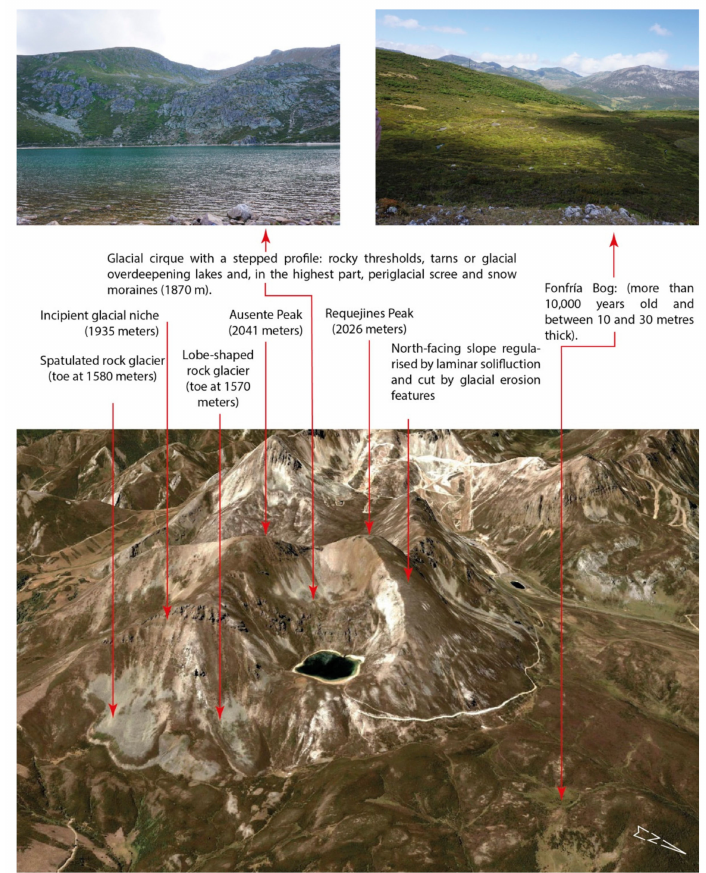
Figure 5. General view (Google Earth image from 2007) of the mountainous alignment between Peña de Requejines and Ausente Peak showing the main landforms that can be recognised on its eastern slope. Photographs by the